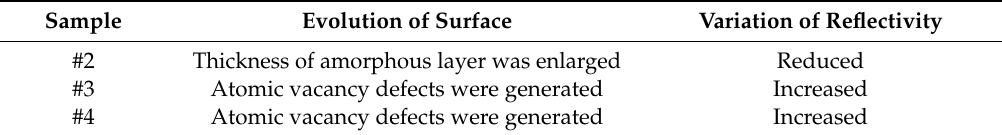
Table 11. The reflectivity variation of three samples contrast to sample #1.